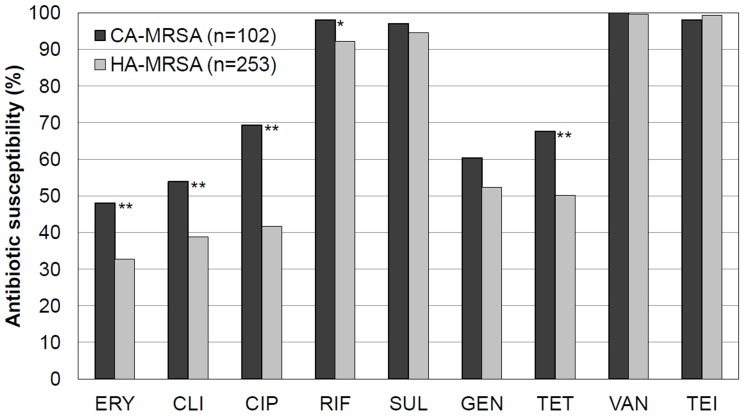
Antibiotic susceptibility profiles of the community-associated methicillin-resistant Staphylococcus aureus (CA-MRSA) isolates and the healthcare-associated MRSA (HA-MRSA) isolates.ERY, CLI, CIP, RIF, SUL, GEN, TET, VAN, and TEI denote erythromycin, clindamycin, ciprofloxacin, rifampin, sulfamethoxazole-trimethoprim, gentamicin, tetracycline, vancomycin, and teicoplanin, respectively. Data for CIP, RIF, SUL, GEN, TET, and TEI were missing for 2, 1, 34, 4, 2, and 1 patient(s), respectively. * and ** indicate statistical significance at P<0.05 and 0.01, respectively (χ2 test).